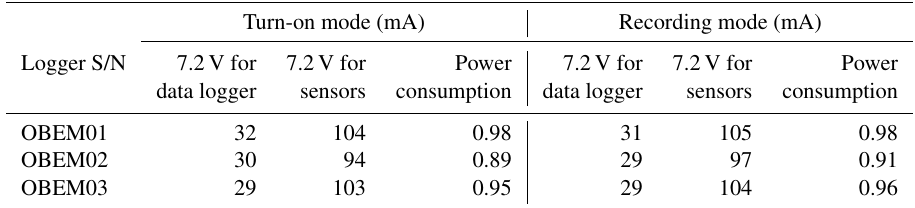
Table 2. The total current consumption of the OBEMs.